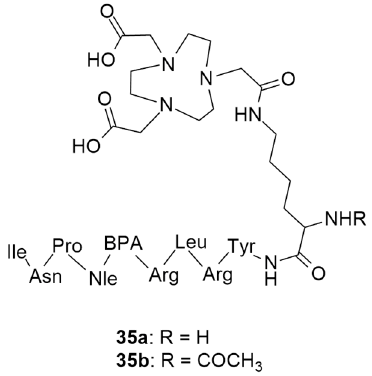
Figure 10. Structures of short NPY analogues functionalized with NOTA ( 35a and 35b ).